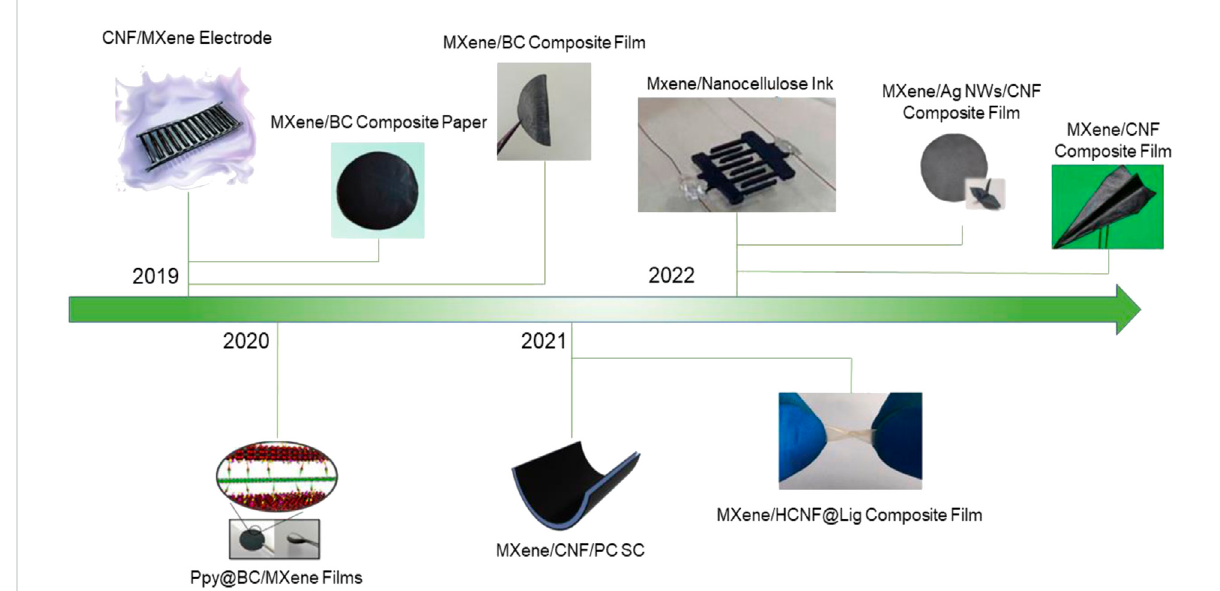
FIGURE 3 Brief timeline of nanocellulose/MXene composites for supercapacitors. Reproduced from: Tian et al. (2019), Wiley-VCH; Jiao et al. (2019), Wiley-VCH; Wang et al. (2019), Wiley-VCH; Song et al. (2020), Springer Nature; Chen et al. (2021a), Elsevier; Chang et al.(2021), Royal Society of Chemistry. Zhou et al. (2022), Wiley-VCH; Tang et al. (2022), Wiley-VCH; Chen et al. (2022), Elsevier.